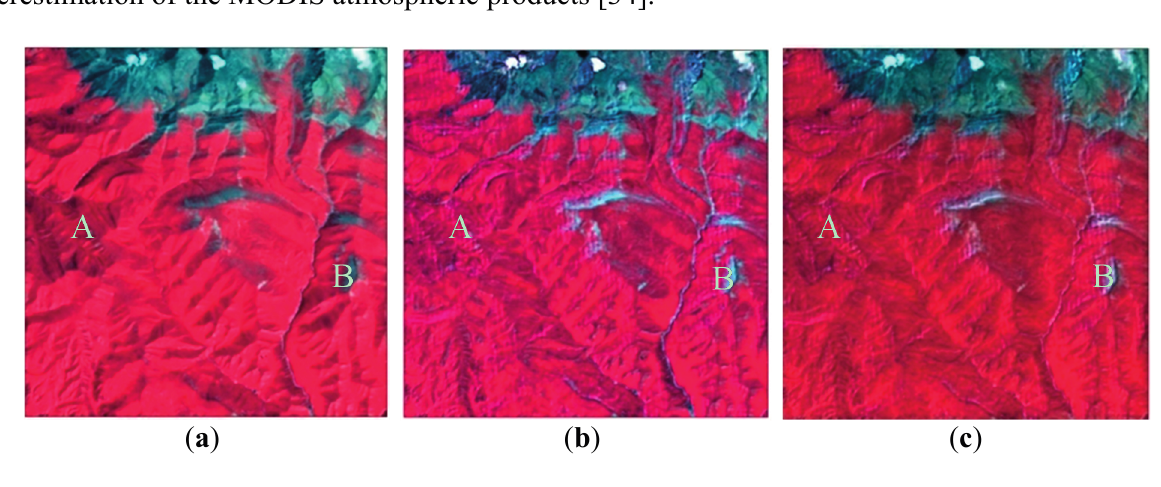
Figure 5. False-color composite (RGB: bands 4, 3, and 2) of the original images and after the topographic normalization: ( a ) the original images; ( b ) MODIS-based Lambertian algorithm (MBLA); and ( c ) MODIS-based BRDF algorithm